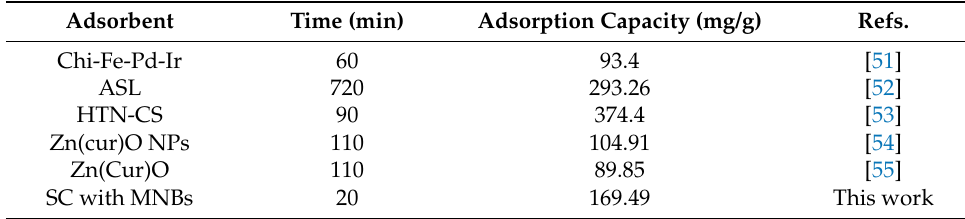
Table 3. Comparison of SC with MNBs and references.